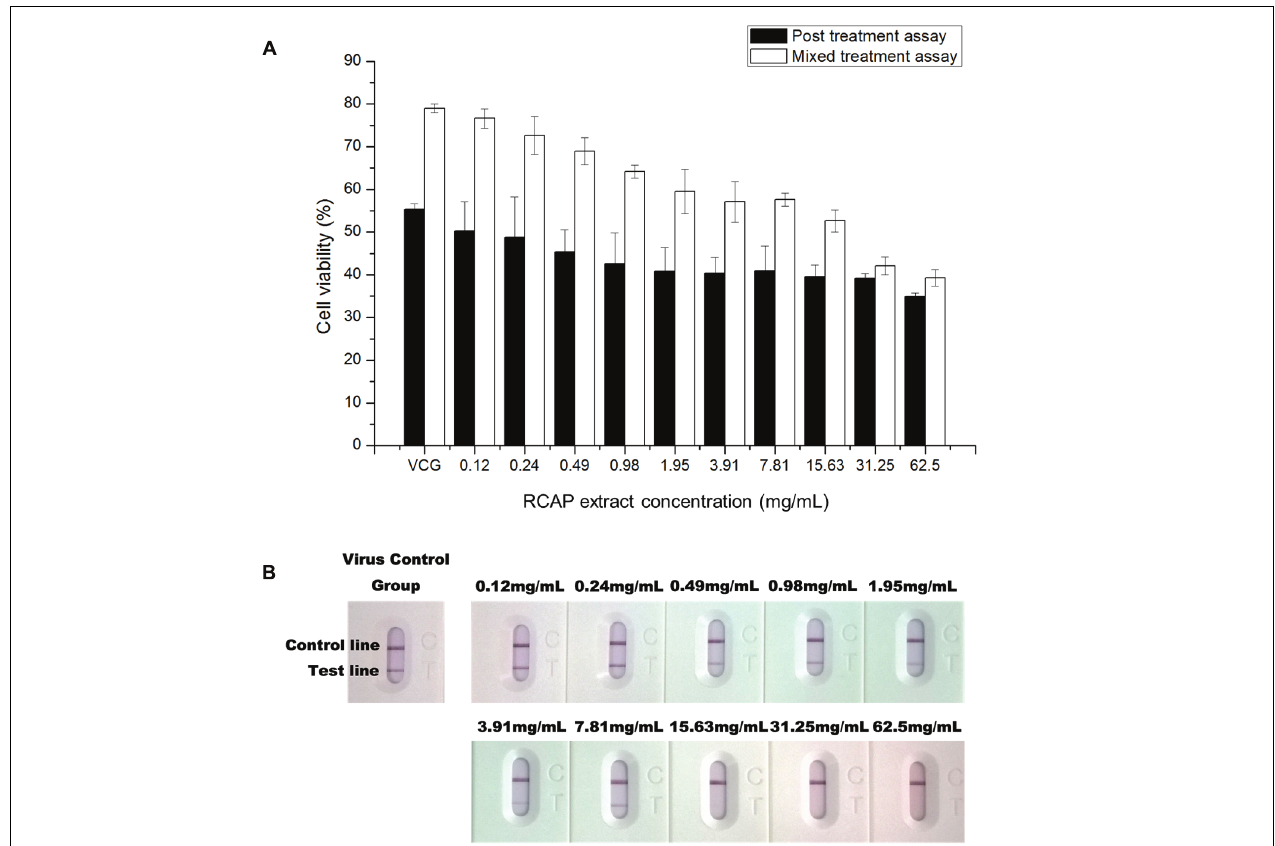
FIGURE 3 | Effect of RCAP on cell viability and viral load in antiviral assay. (A) Cell viability of each group in mixed and post treatment assay. Cell viability was calculated as OD